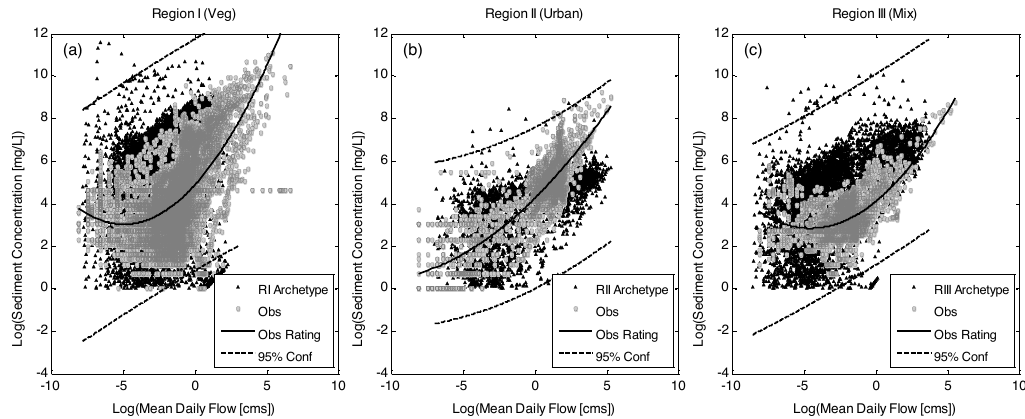
Fig. 4. Solid lines are the log(suspended sediment) rating curves (second order) for observed sites within (a) Region I, (b) Region II and (c) Region III. Dashed lines are the ± 95% confidence intervals for the simulated log(suspended sediment) rating